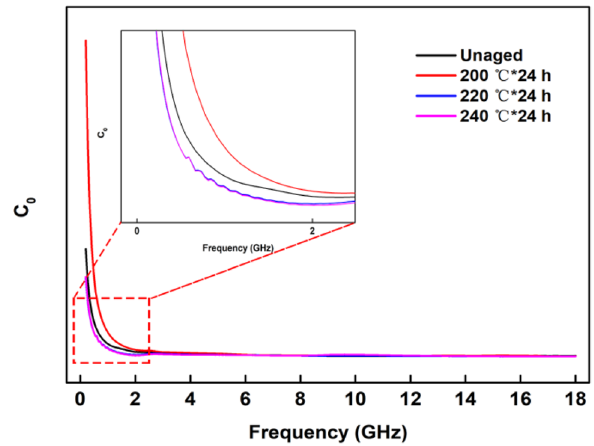
Figure 8. C 0 - f curves of the MPVQ/CIPs/GR composites.